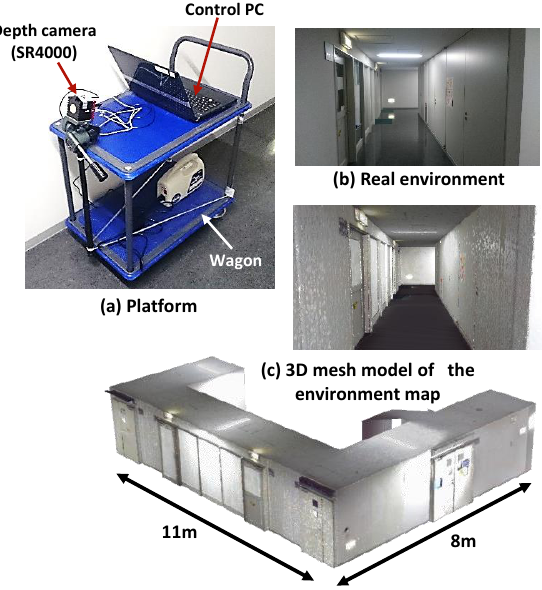
Figure 4. The platform and the environment map